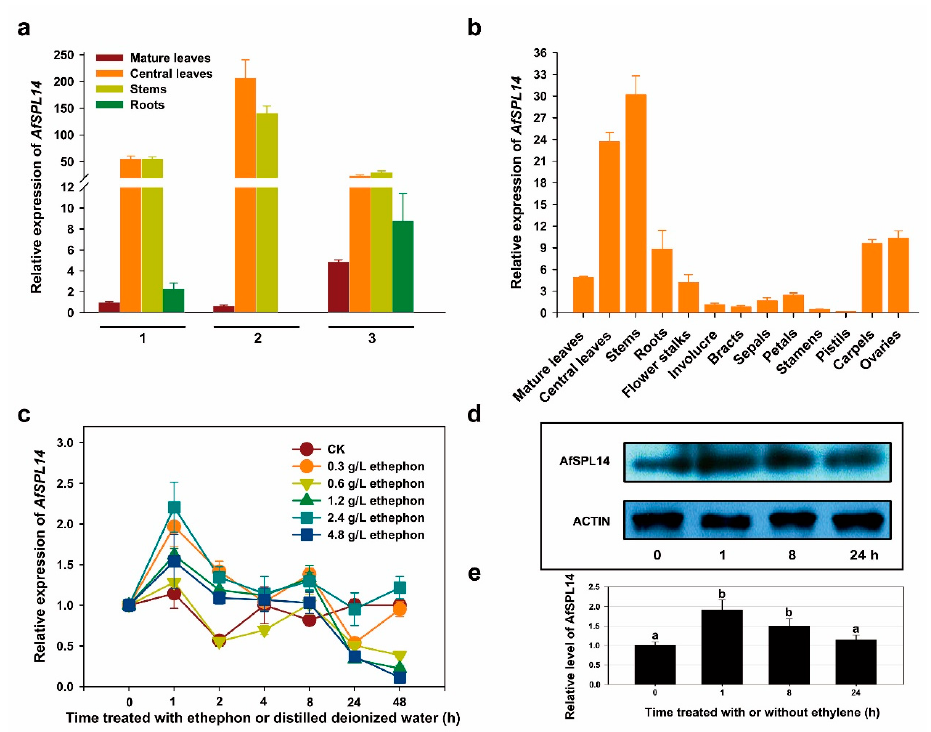
Figure 4. Expression of AfSPL14 transcripts in various tissues of A. fasciata and immunoblot analysis of AfSPL14 in central leaves treated with or without ethephon. ( a ) Expression level of AfSPL14 transcripts in various tissues of juvenile and adult plants. (1) juvenile plants; (2) adult plants prior to flower bud differentiation; (3) 39-DAF flowering adult plants. Samples were collected at 10:00 am. ( b ) Expression level of AfSPL14 transcripts in the vegetative and reproductive organs of 39-DAF flowering adult plants. Samples were collected at 10:00 am. ( c ) Expression level of AfSPL14 transcripts in the central leaves of A. fasciata in response to exogenous ethephon treatment at different concentrations for different time. In the panels, 0, 1, 2, 4, and 8 h represents the samples collected at 10:00, 11:00, 12:00, 14:00, and 18:00, respectively; 24 h and 48 h represent the treated samples collected at 10:00 am at the next day and the next two days, respectively. For CK, 10 mL of distilled deionized H 2 O was poured into the cylinder shapes of A. fasciata . 0 h represents the samples treated without ethephon or distilled deionized H 2 O. ( d ) Immunoblot analysis of the AfSPL14 protein level in the central leaves of A. fasciata treated with 10 mL of 0.6 g · L − 1 exogenous ethephon for 1, 8, and 24 h, or without ethephon (0